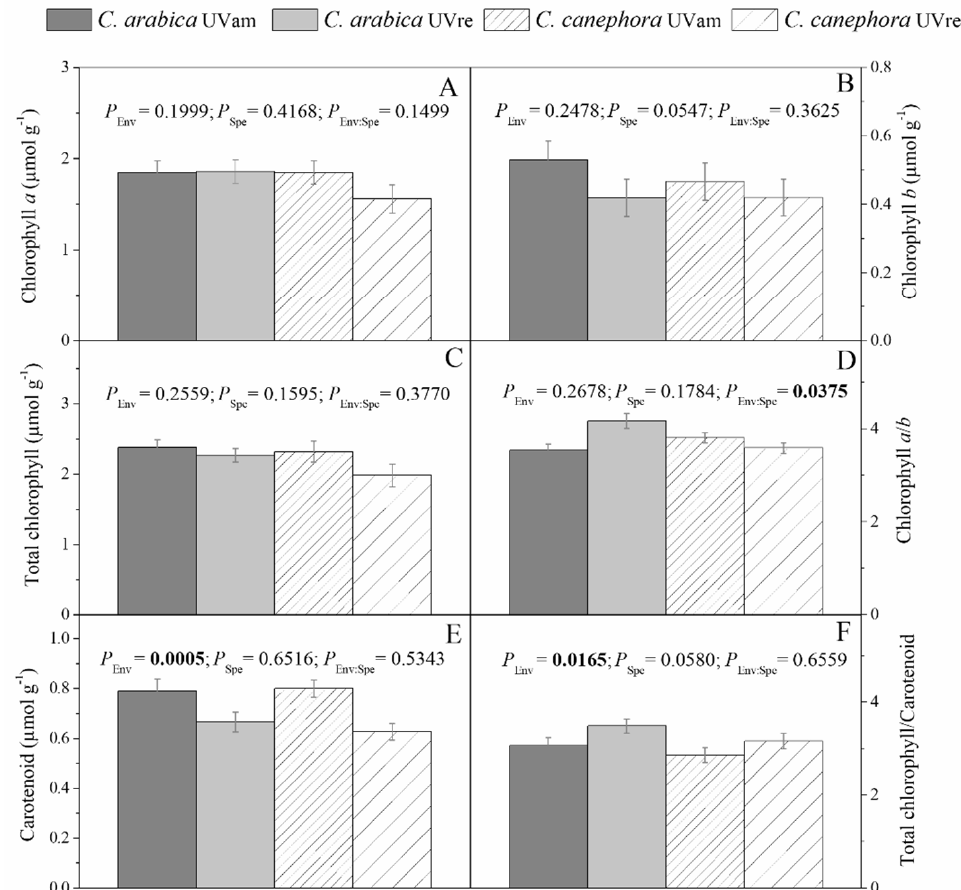
Figure 5. ( A ) Variations in contents of chlorophyll a ( A ), b ( B ), and total ( C ), chlorophyll a / b ratio ( D ), carotenoid content ( E ), and total chlorophyll ( F )/carotenoid ratio for Coffea arabica and C. canephora grown under UV near ambient conditions (UVam) and reduced (UVre) levels (Env). The marginal significance was considered as 0.1. Estimated mean values ± S.E. (n = 8) and ANOVA p -Values for effects of species and UV regimes are shown. ANOVA p -Values < 0.05 are marked in bold. Linear electron transport (LEF), measured in light-adapted leaves, was not altered by UV radiation (Figure 6A). However, higher LEF values were obtained in C. canephora , maintaining greater values than C. arabica during all evaluated diurnal periods. LEF values were higher until 1.00 p.m., decreasing afterwards, for both species in both UV